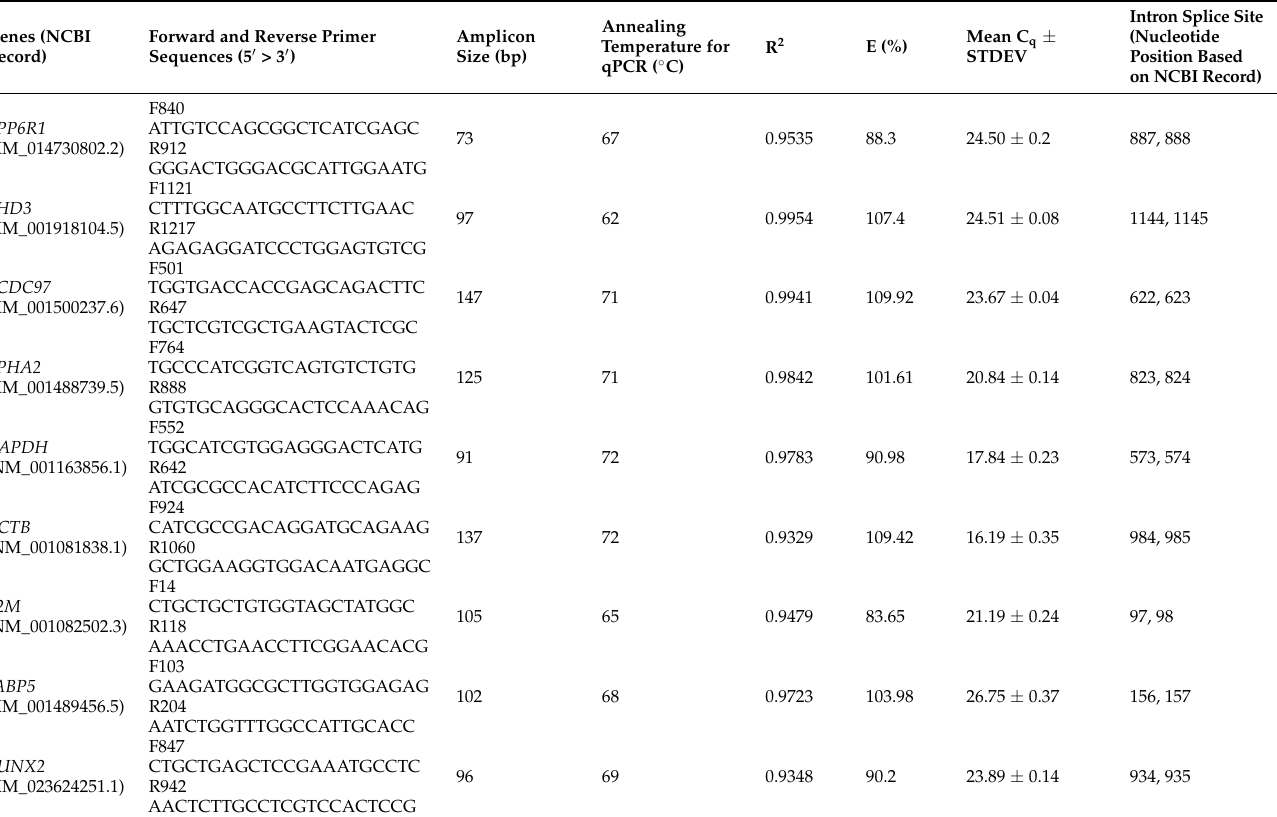
Table 3. Select candidate RGs and TGs, primer sequences, annealing temperatures, amplicon size in base pairs (bp), their respective PCR efficiencies, and mean C q values assessed in a pooled sample consisting of cDNA from parental ADSCs and differentiated adipocytes and osteoblasts, and intron splice site. R 2 : correlation coefficient; E: PCR efficiency (%); STDEV: standard